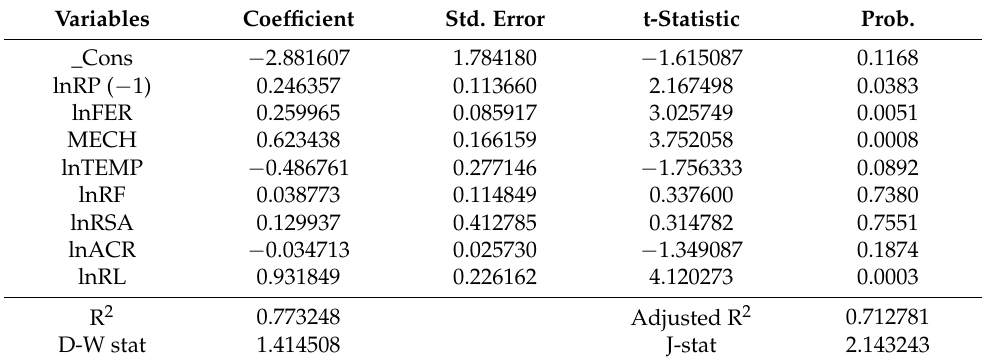
Table 4. The effect of technical progress and climate change on rice productivity (Model